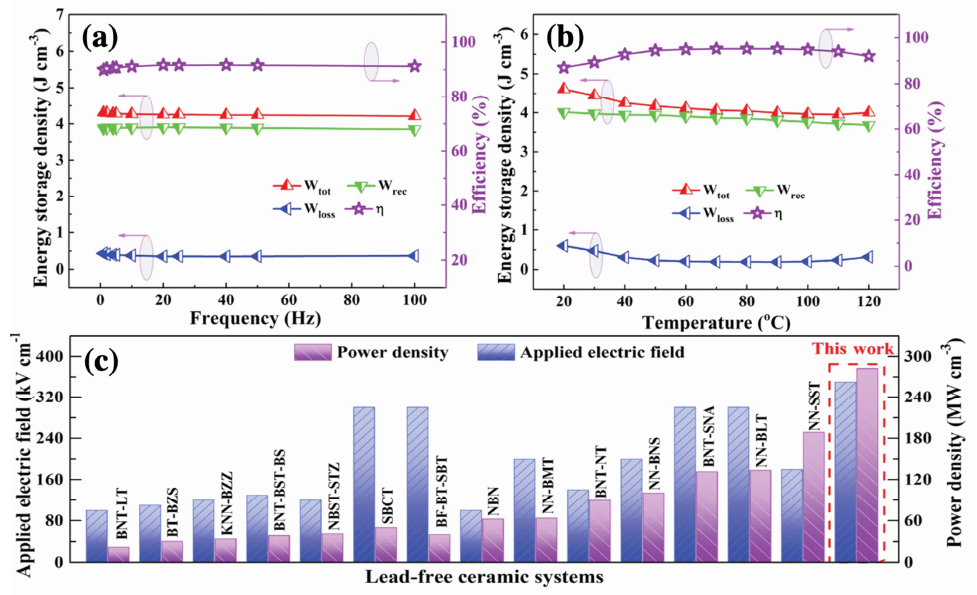
Figure 5. Energy storage performance dependent ( a ) frequency, ( b ) temperature for 0.35BiFeO 3 –0.65SrTiO 3 ceramics. ( c ) The power density and applied electric field between other lead-free system and 0.35BiFeO 3 –0.65SrTiO 3 ceramics. Reprinted with the permission of [65]. Copyright © 2022 John Wiley and Sons.